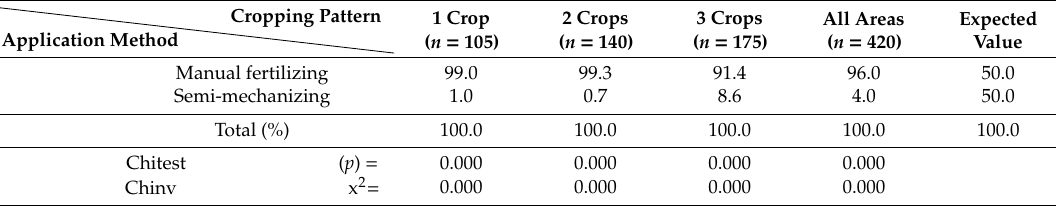
Table 11. Current status of fertilizer application method (%).